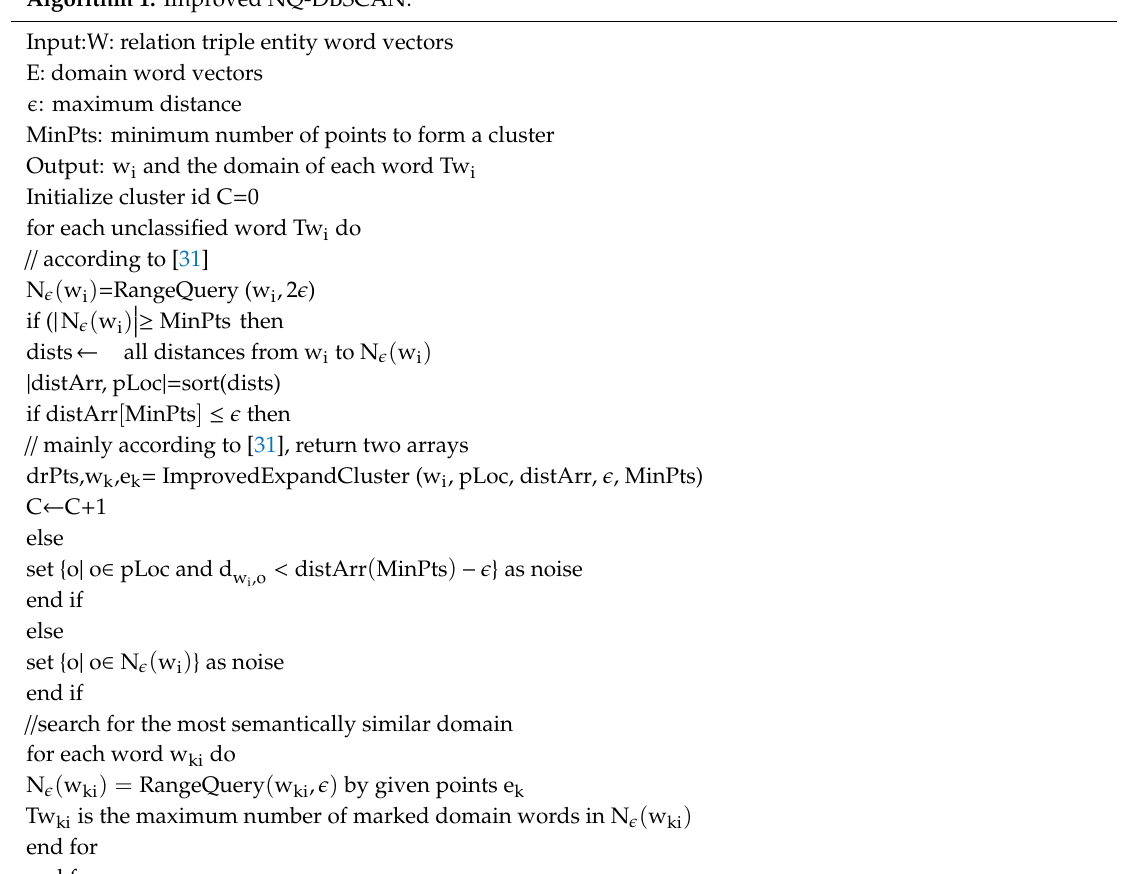
Algorithm 1: Improved